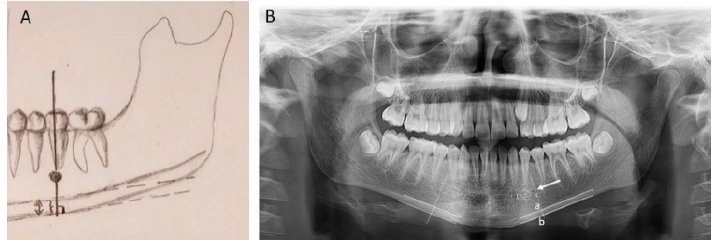
Figure 1. Mandibular cortical width (MCW) measurement: ( A ) A graphical representation of a MCW measurement. ( B ) A panoramic radiograph showing the measurement of mandibular cortical width. A line parallel to the long axis of the mandible and tangential to the inferior border of the mandible was drawn. A line perpendicular to this tangent and intersecting the mental foramen (dotted line) was constructed, along which the mandibular cortical width was measured. The distance between the two parallel solid lines a–b is the cortical width.